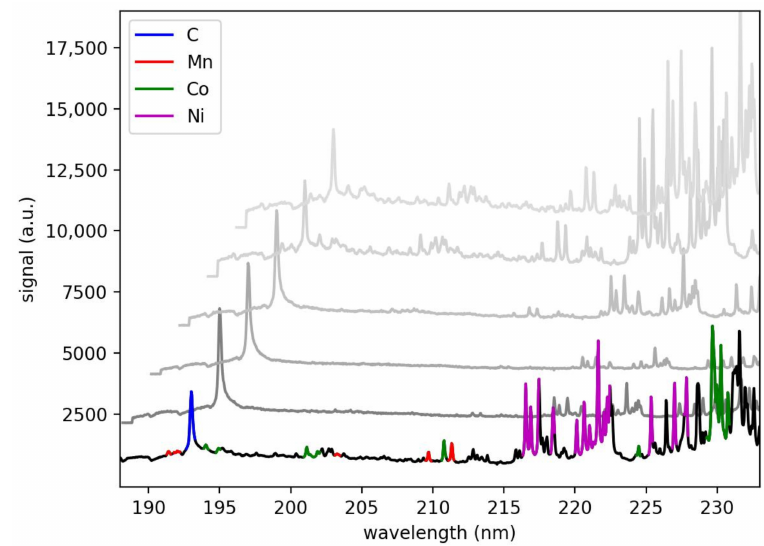
Figure 4. LIBS Spectrum of an NMC-cathode in the range between 190–235 nm, showing the elements Ni, Co, Mn and C averaged over 200 positions and 10 pulses per position. Colored lines are used in the evaluation. The gray shifted lines show single pulses of a depth profile (pulse 1,3,5,7,9 in rising order).